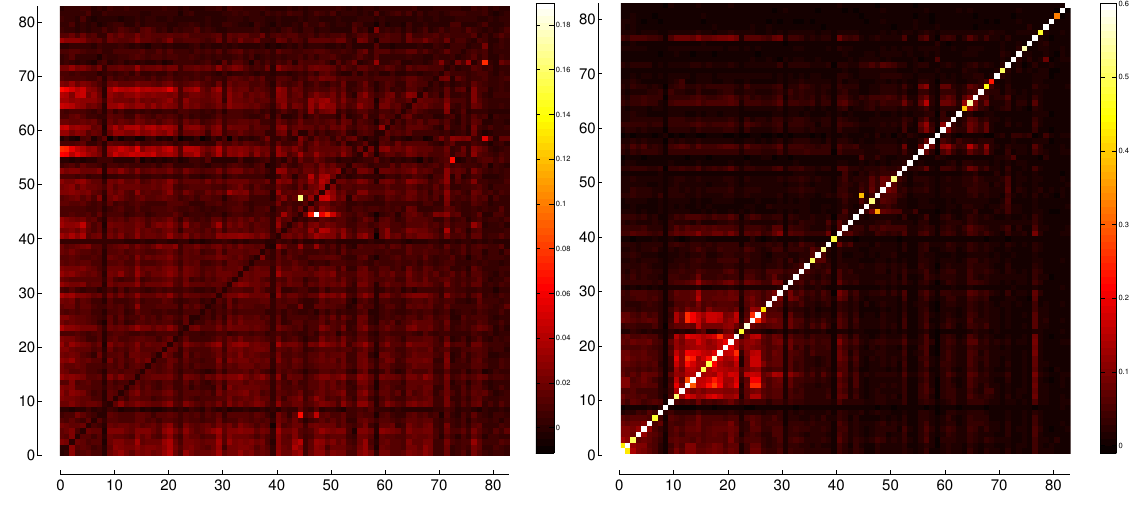
Figure 20. Heat maps of the correlation and lagged ETE matrices for the absolute values of log